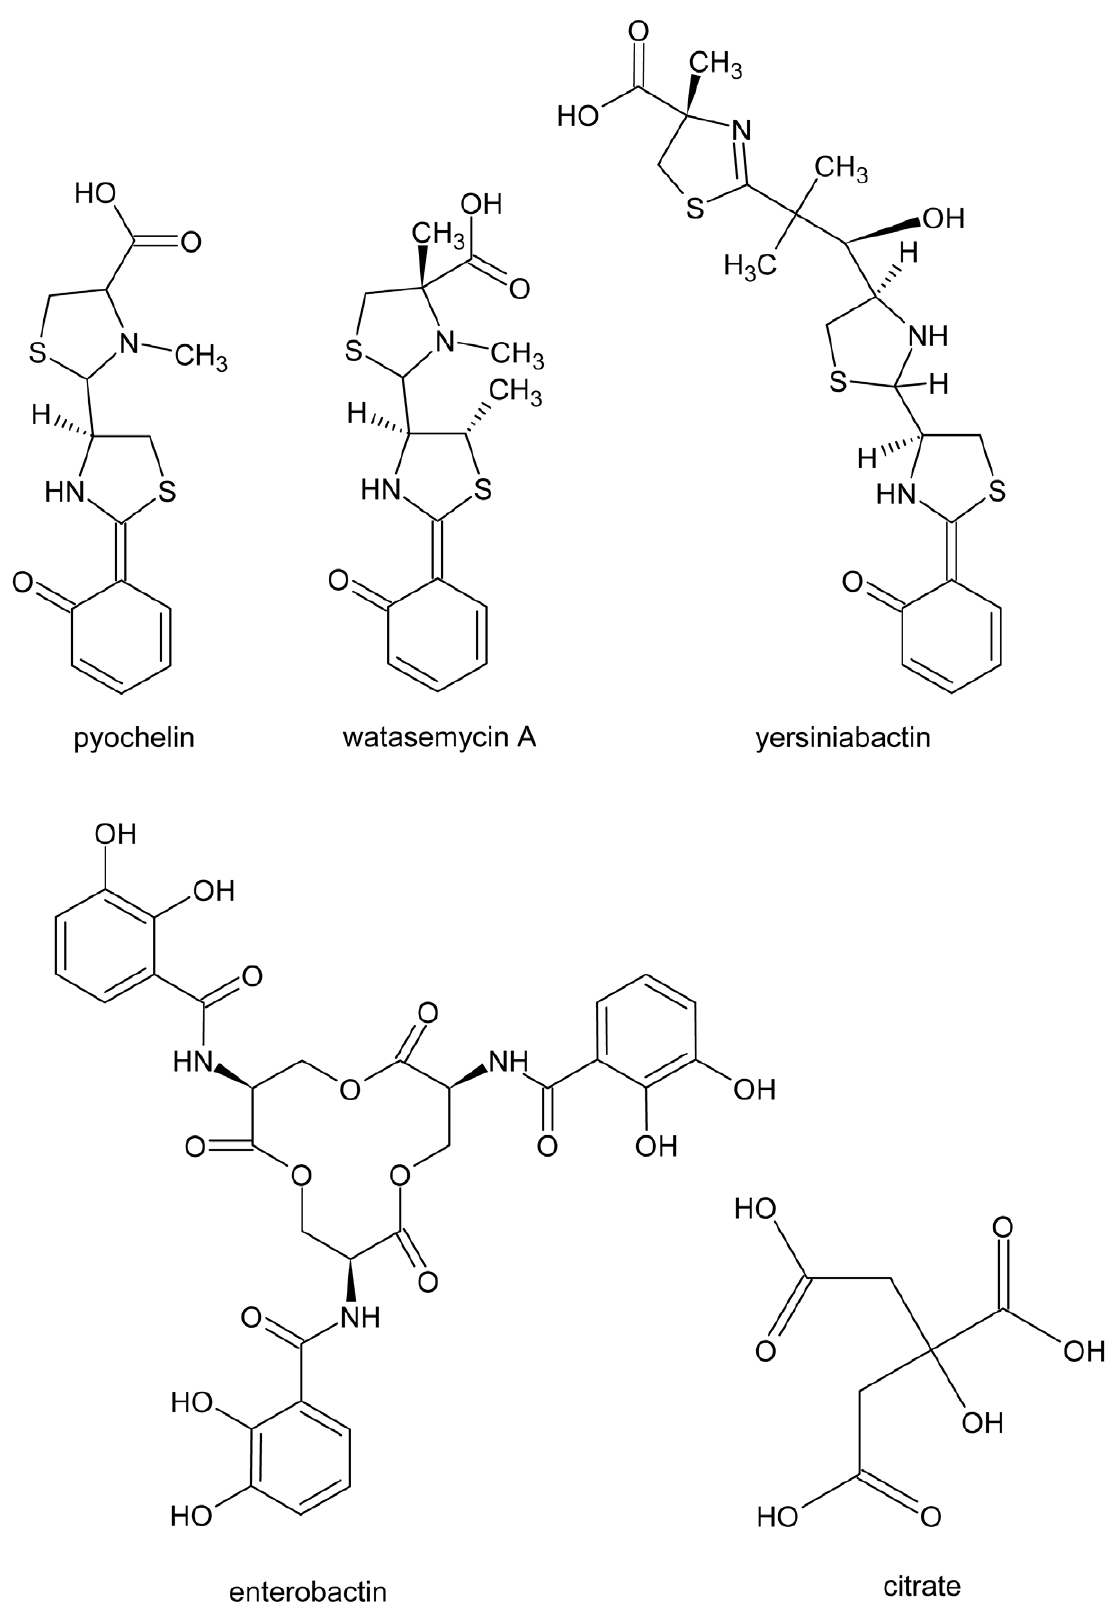
Figure 1. Chemical structures of the siderophores pyochelin, watasemycin A, yersiniabactin, enterobactin and citrate.